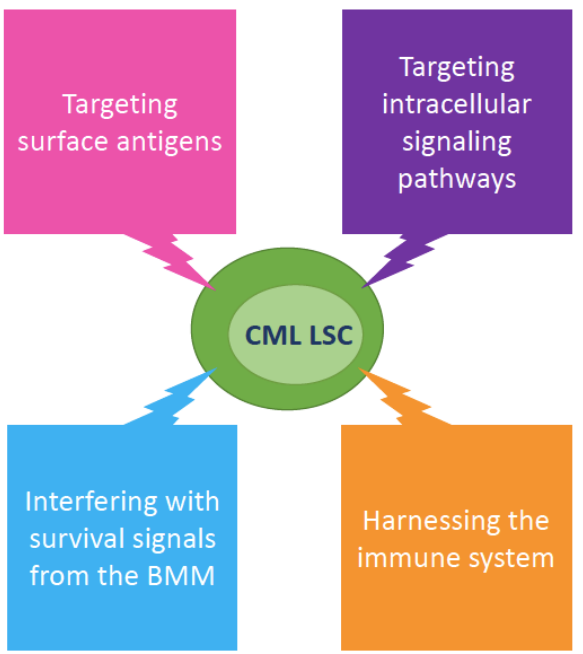
Figure 5. Overview of the therapeutic strategies that have been proposed to eradicate CML LSCs. Abbreviations: BMM, bone marrow microenvironment.